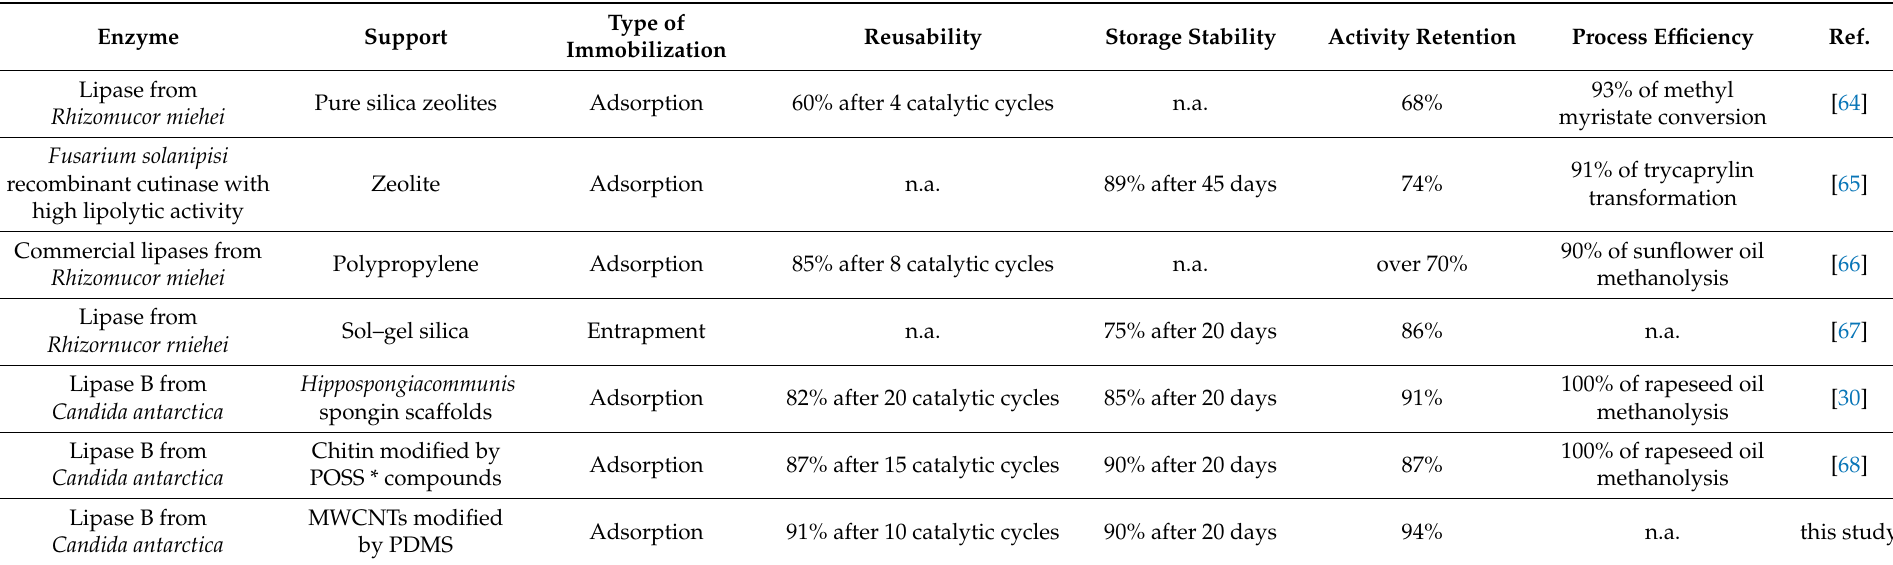
Table 3. Comparison of the most important parameters of lipase immobilized using various support materials. n.a.—not